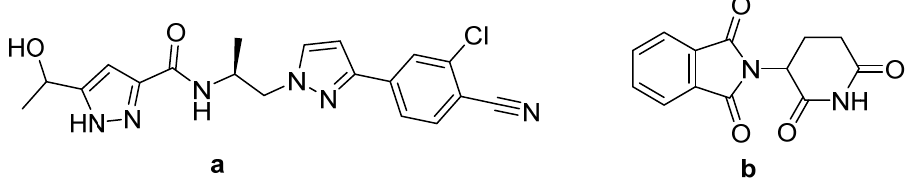
Figure 1. Structural formula of ( a ) darolutamide and ( b ) (R)-thalidomide. (R)-Thalidomide, a non-steroidal antiandrogen drug, is used for the treatment of different types of cancer, such as multiple myeloma and prostate cancer [1]. Thalidomide is 2-[(3R)-2,6-dioxopiperidin-3-yl]-2,3-dihydro-1 H -isoindole-1,3-dione (Figure 1) [5].